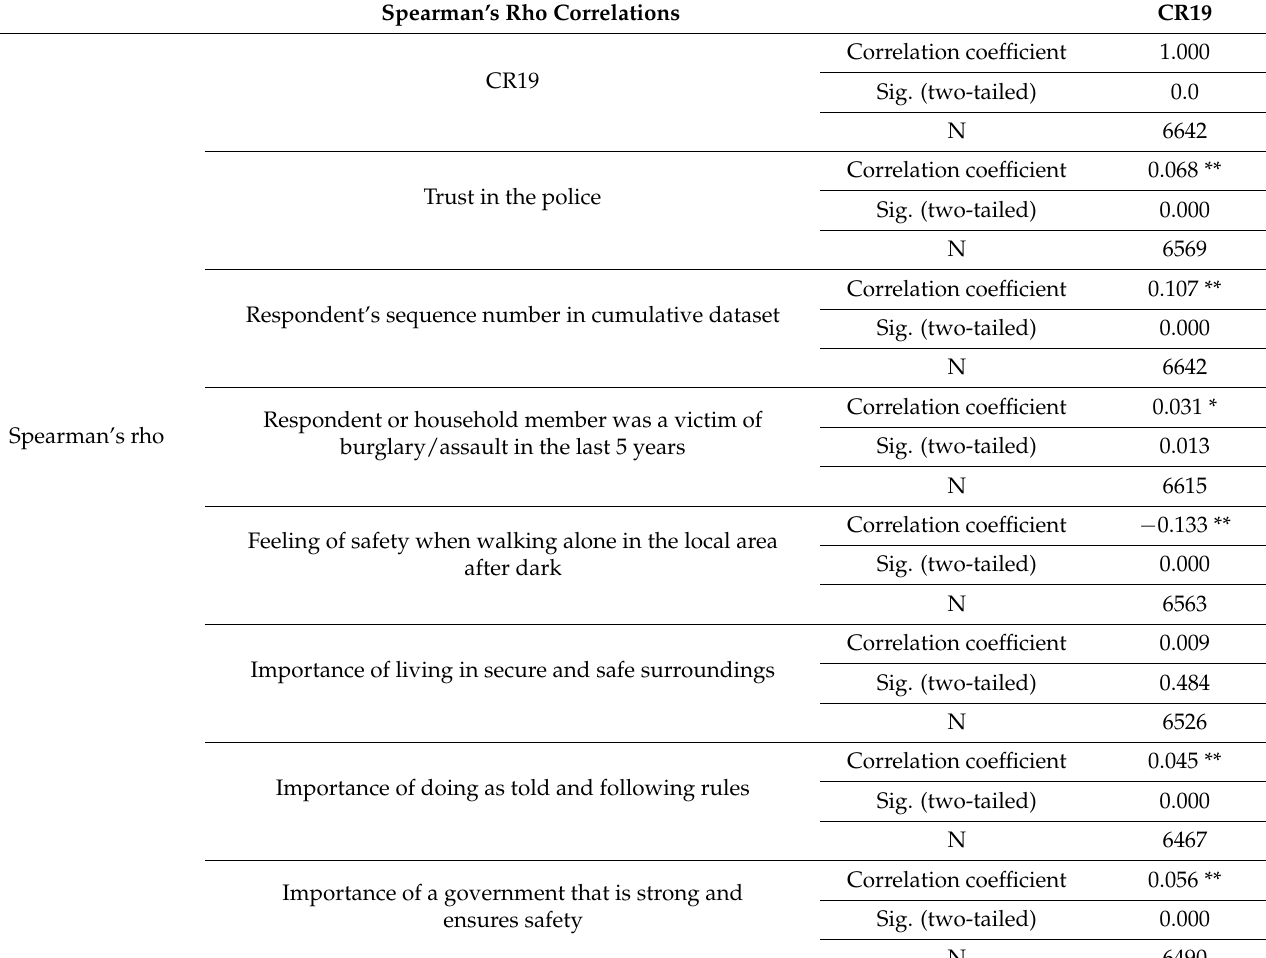
Table 1. Correlation analysis of study variables and crime